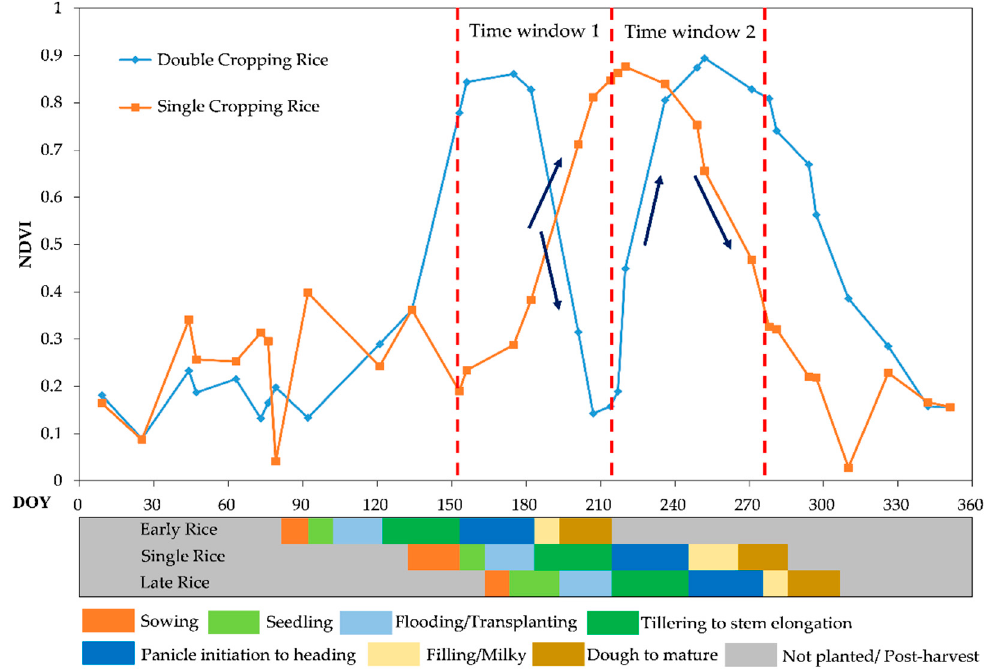
Figure 4. Temporal profiles of NDVI for different rice cropping systems and the rice calendar. NDVI values were calculated from the Landsat images of P121R40 from 2013 to 2016. The double cropping rice site is located in 28°52.39"N, 116°33.12'E and the single cropping rice site in 28°56.85'N, 116°4.97'E. Note: DOY = day of year.